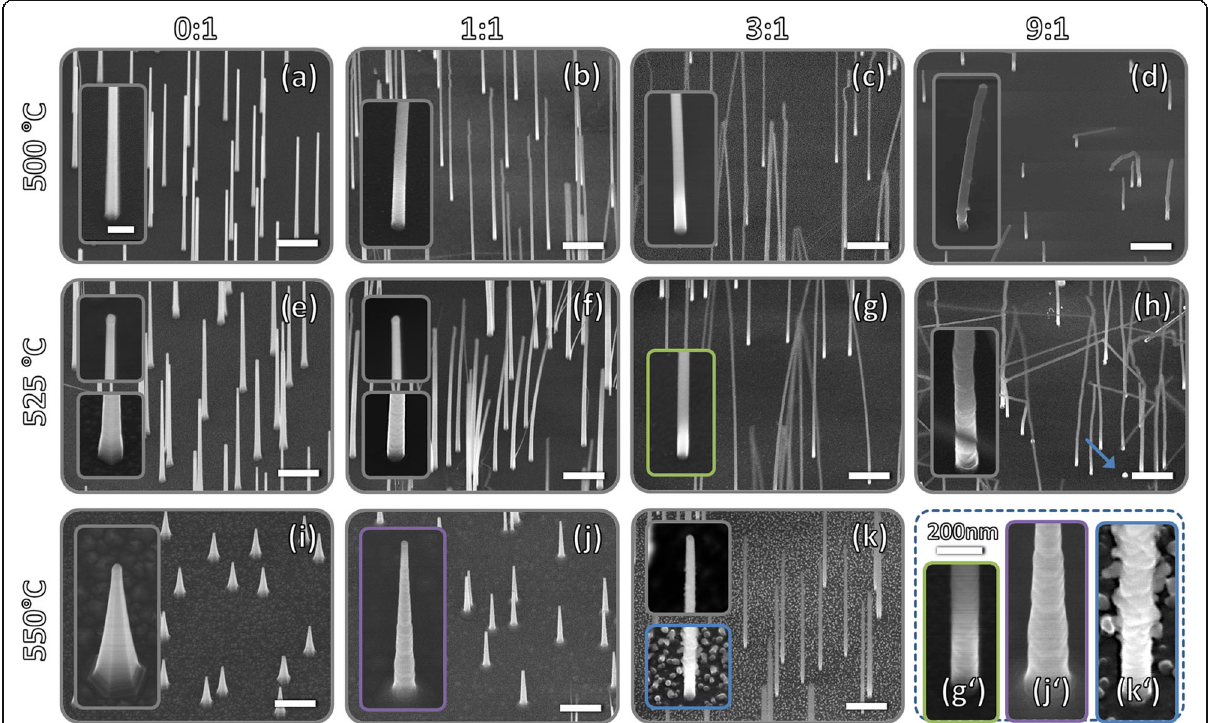
Fig. 1 VLS-grown GaP(N) nanowires on GaP(111)B. UDMH:TBP ratio and temperature were varied from 0 to 9 and 500 to 550 °C, respectively. The growth time was always 16min. All overview and close-up scans were taken at 30° tilt and have the same scale, respectively, with the measuring bars being 2 μ m or 200nm. In (g ′ ), (f ’ ), and (k ’ ) enlarged close-ups are shown for a clear visibility of the